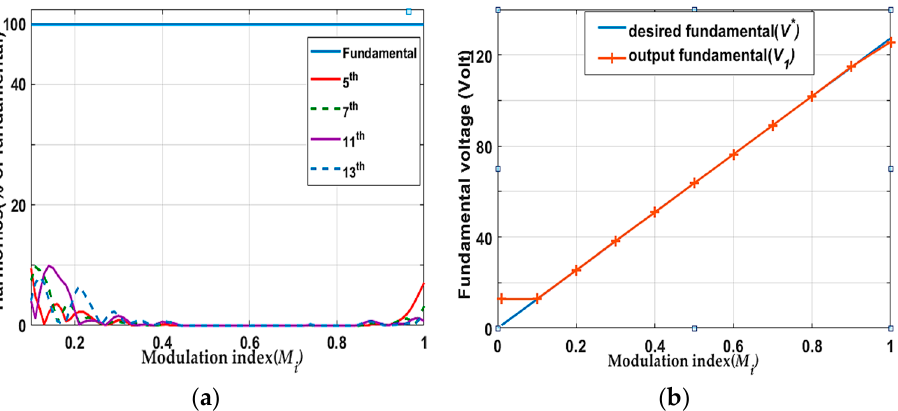
Figure 5. ( a ) Harmonics order of fifth, seventh, eleventh, and thirteenth versus modulation index; ( b ) The desired and output fundamental versus modulation index.